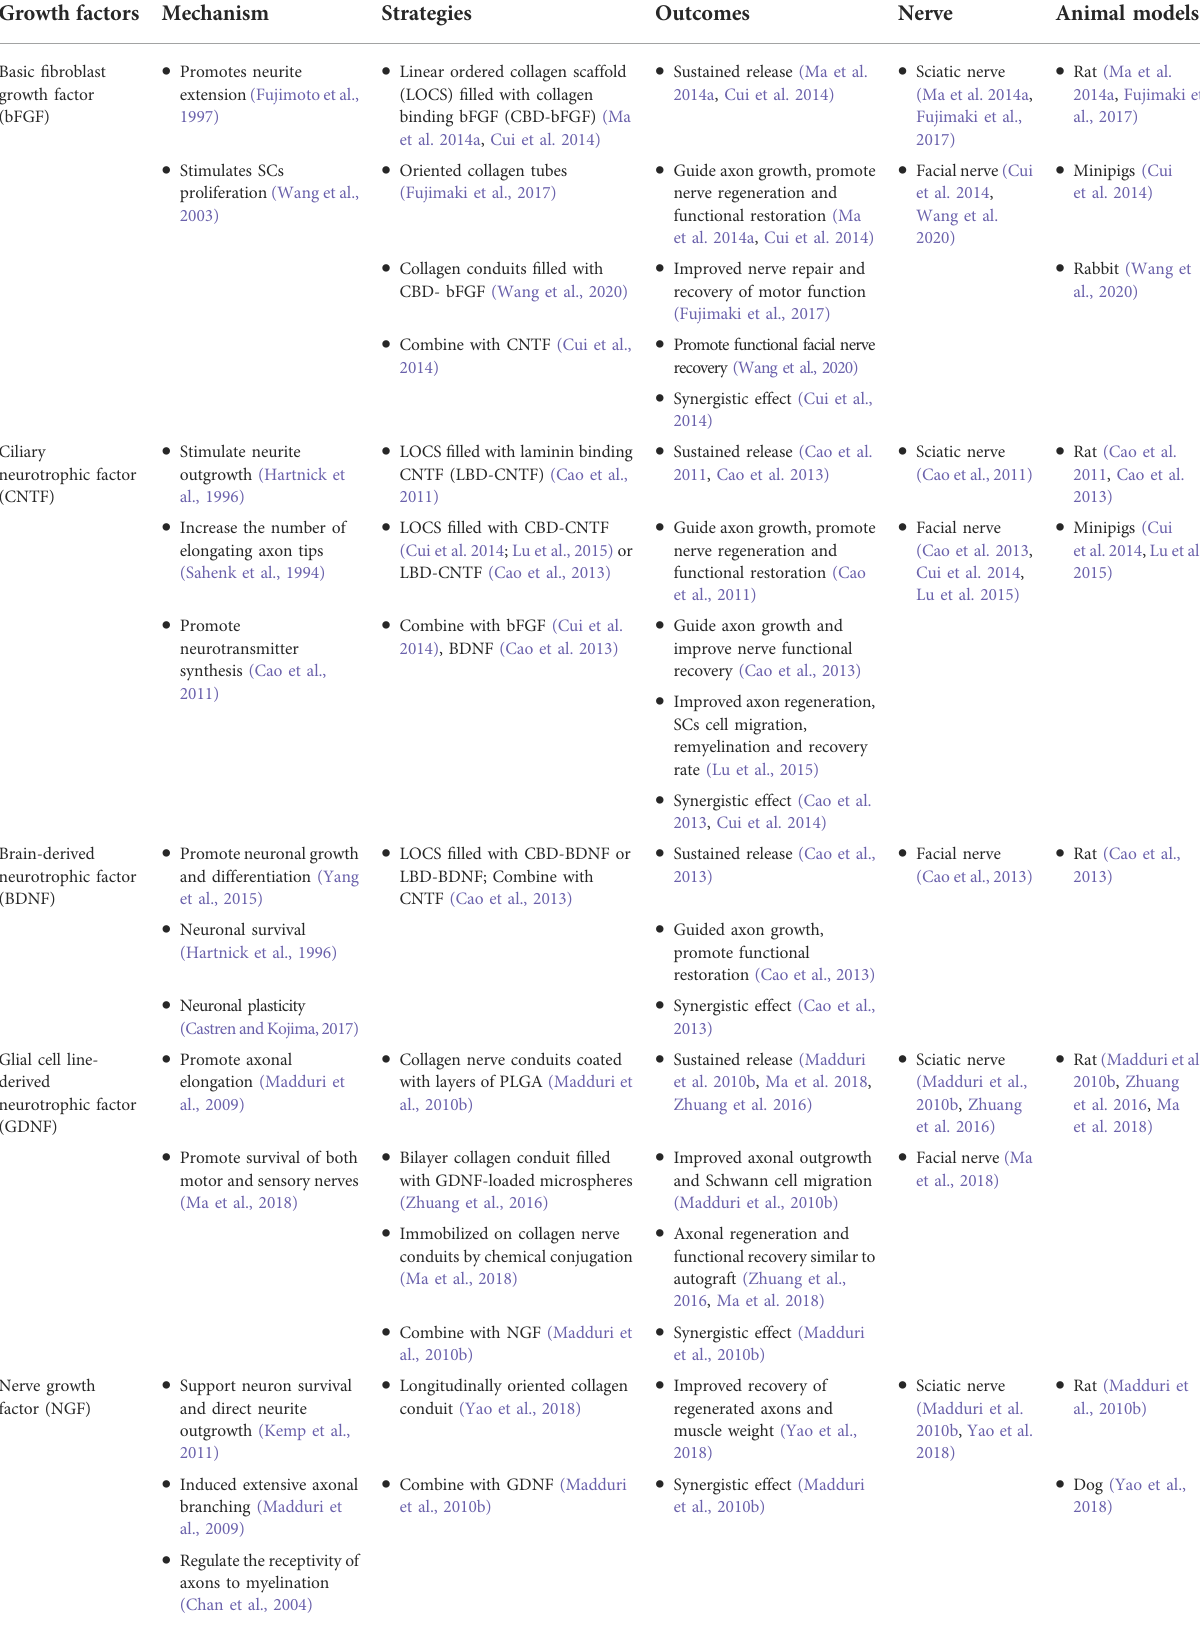
TABLE 2 Growth factors fi ll in collagen material to repair